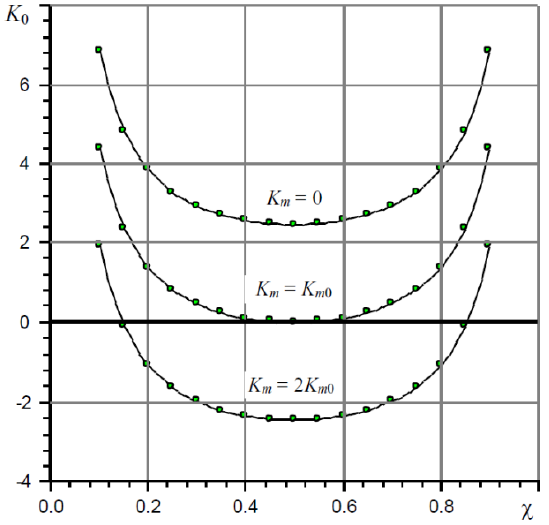
Figure: 4. Curves of dependence of compliance K 0 on para– meter χ at different values of the membrane compliance K m